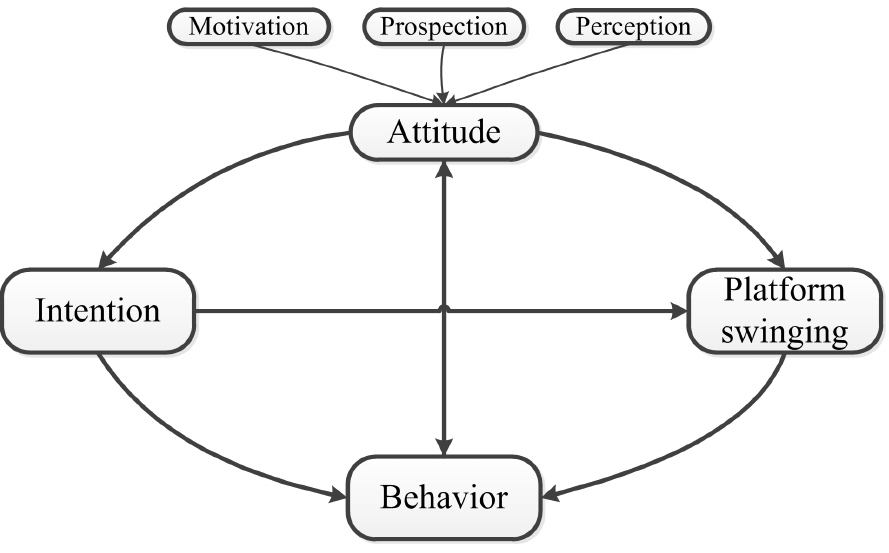
Figure 2. Category Relationship